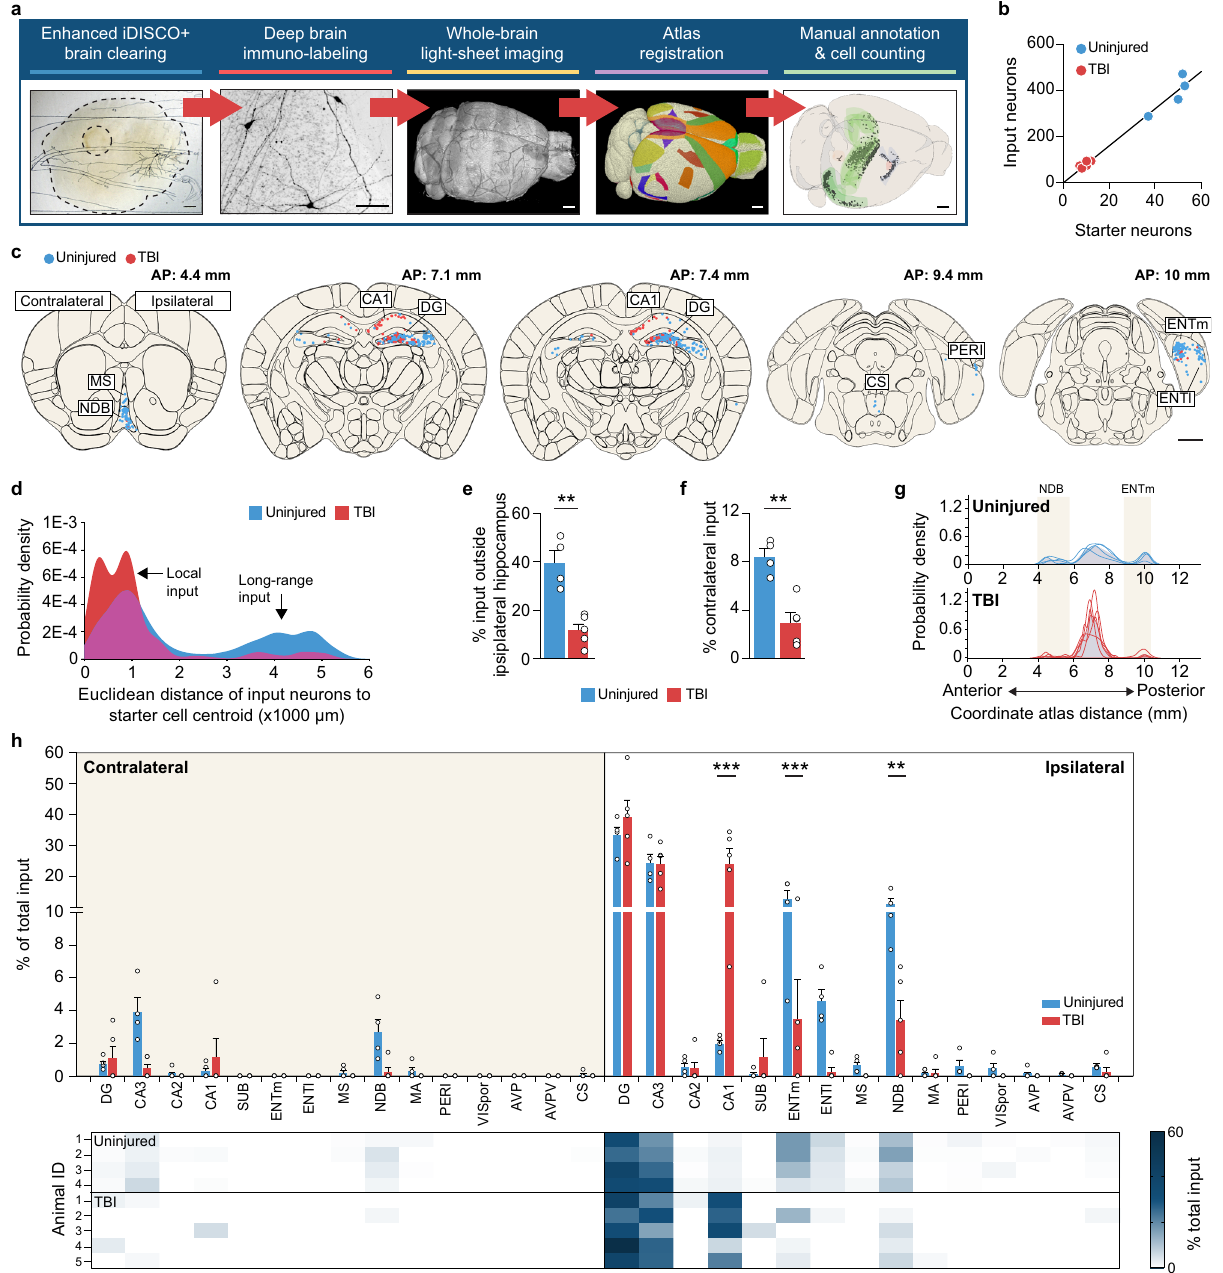
Fig. 2 Reorganization of brain-wide input to hippocampal SST interneurons after TBI. a Experimental design for enhanced iDISCO + brain clearing and whole-brain light-sheet imaging. b Linear regression analysis for number of starter cells and pre-synaptic input neurons in the whole brain ( n = 4 uninjured controls, 5 TBI mice; R 2 = 0.98). c Schematic coronal sections (250 μ m) showing individual rabies-labeled cells registered in standardized atlas space for uninjured controls (blue) and brain-injured animals (red). One dot represents one neuron. n = 4 uninjured control and 5 TBI animals. A list of abbreviations is provided in Supplementary Data 2. d Gaussian kernel cell density plots showing pooled Euclidian distances of input neurons to nearest starter neuron centroid. e . Proportion of input neurons found outside ipsilateral hippocampus (DG, CA3, CA2, CA1). Uninjured: 39.6 ± 5.2%, n = 4 mice; TBI: 11.8 ± 2.7 %, n = 5 mice; ** P = 1.5E-3; two-tailed t -test. f Proportion of input neurons found in the contralateral hemisphere. Uninjured: 8.4 ± 0.7%, n = 4 mice; TBI: 3.0 ± 0.8 %, n = 5 mice; ** P = 2.0E-3; two-tailed t -test. g Gaussian kernel cell density plot of the whole-brain distribution of input neurons along the anterior-posterior axis. Grey shading represents the pooled population with individual lines representing each animal. Quanti fi cation is provided in Supplementary Data 3. h Proportion of input neurons found in each discrete brain area. *** P < 1.0E-15, uninjured versus TBI (CA1), *** P = 2.25E-04, uninjured versus TBI (ENTm), ** P = 4.69E-03, uninjured versus TBI (NDB); two-way repeated-measures ANOVA with Bonferroni ’ s post-hoc test; n = 4 uninjured and 5 TBI mice. Quanti fi cation is provided in Supplementary Data 4. Error bars, s.e.m.; scale bars, 1 mm (except deep immunolabeling in a, 100 μ m). See also Supplementary Figs. 3 to 7, Supplementary Data 5, and Supplementary Movies 1 and 2. Source data are provided as a Source Data fi